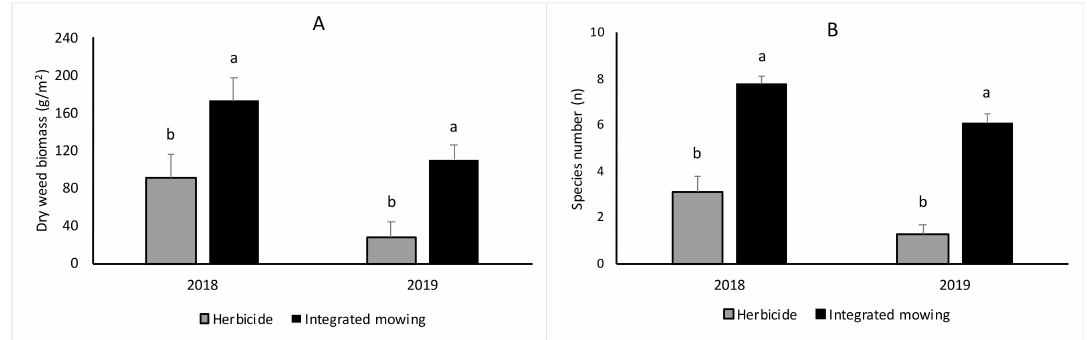
Figure 5. E ff ects of treatment on dry weed biomass ( A ) and species number ( B ) during the summer season. Bars represent standard error. Bars with di ff erent letters in a year are significantly di ff erent at p ≤ 0.05 (Tukey–Kramer HSD